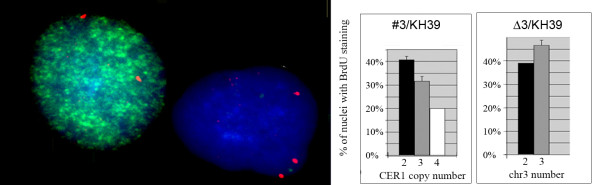
The S-phase fraction of cells increases with loss of an extra 3p21 copy. Living cells of the MCHs #3/KH3 and Δ3/KH39 were incubated with BrdU in final concentration 30 μg/ml during 1 hour followed by fixation with methanol: acetic acid (3:1). FISH with biotin-labeled 3p21-specific RP6-123i13 probe and centromere-specific probe was performed to analyze the #3/KH3 and the Δ3/KH39 respectively. The probe signal was developed using Cy3-conjugated streptavidin (red), while FITC-conjugated anti BrdU antibodies (Roche Molecular Biochemicals Mannheim, Germany) identified cells in S-phase (green). Percentage of S-phase cells in subpopulations of cells with different 3p21 copy numbers in the #3/KH39 and with different chr3 copy number (counted by number of centromeres) in the Δ3/KH39 was calculated in more than 100 nuclei. The calculation was repeated three times when number of cells allowed. The average values and standard deviations are shown.